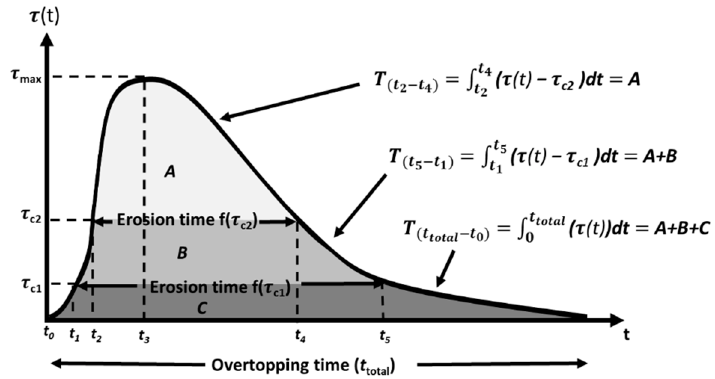
Figure 1. Excess shear stress integral over time for different critical thresholds.